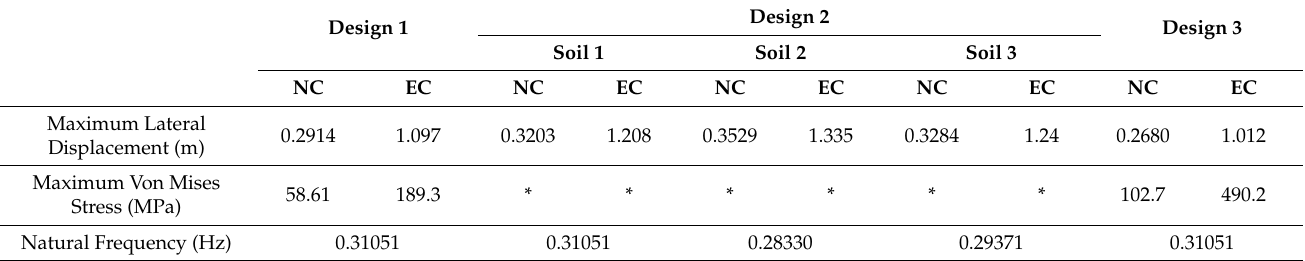
model, which is not surprising because the first model was only made of a single part.